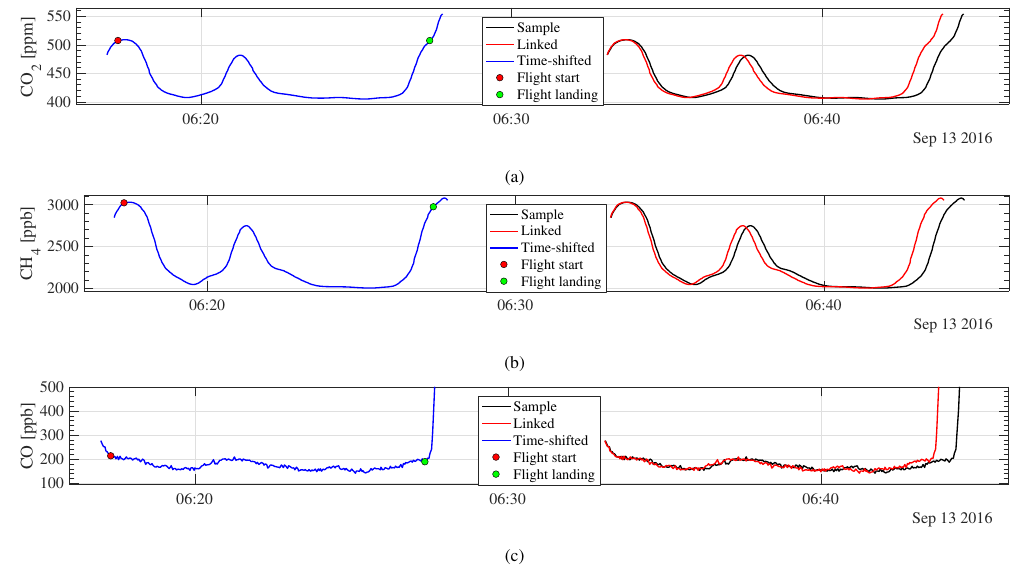
Figure 6. The analysis of CO 2 (a) , CH 4 (b) , and CO (c) for the second flight on 13 September 2016 with its original analysis time, the data-logger-linked time series, and the shifted data-logger-linked time series of the analysis. The red and the green dots represent the time when the drone took off and landed, respectively.